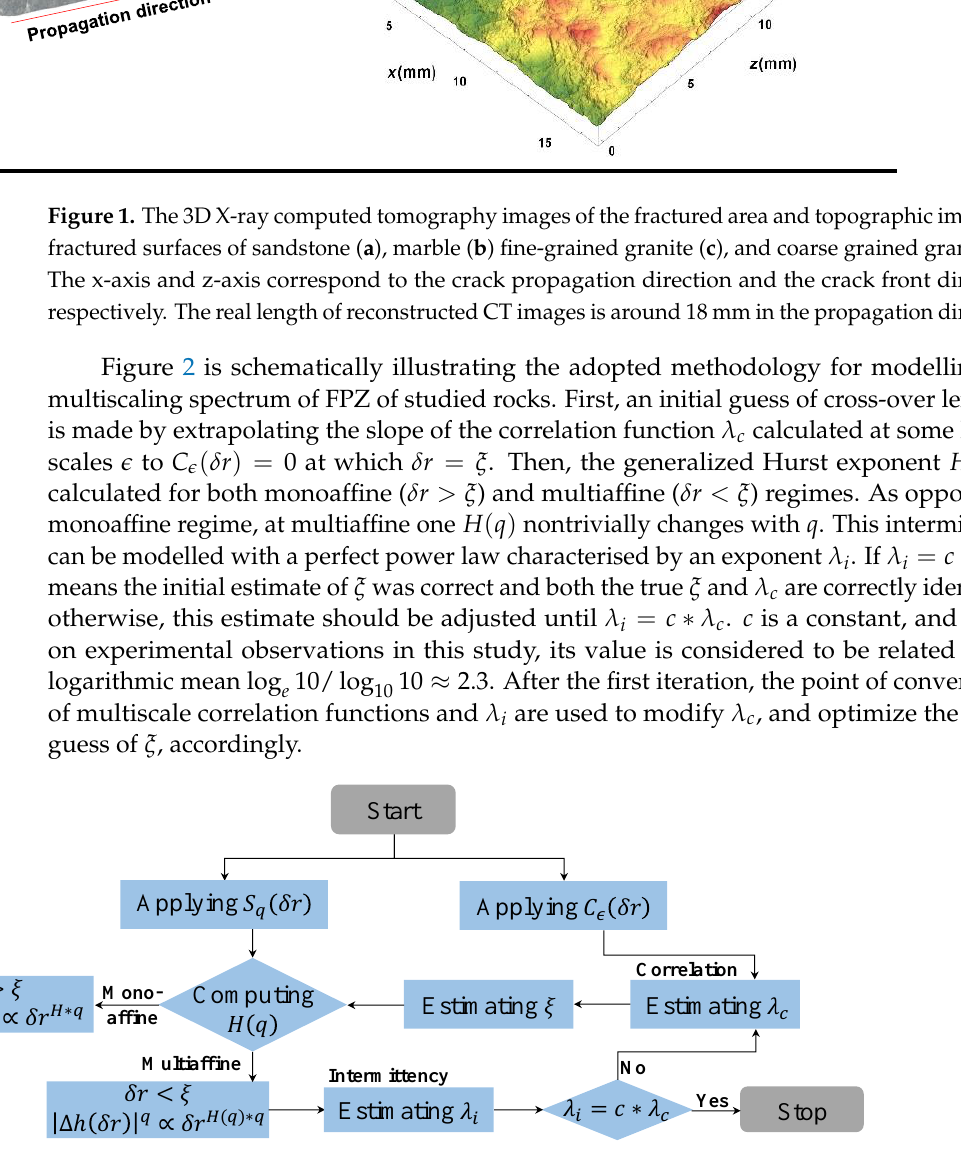
Figure 2. The outline of the adopted methodology for modelling the multiscaling spectrum of FPZ of studied rocks.